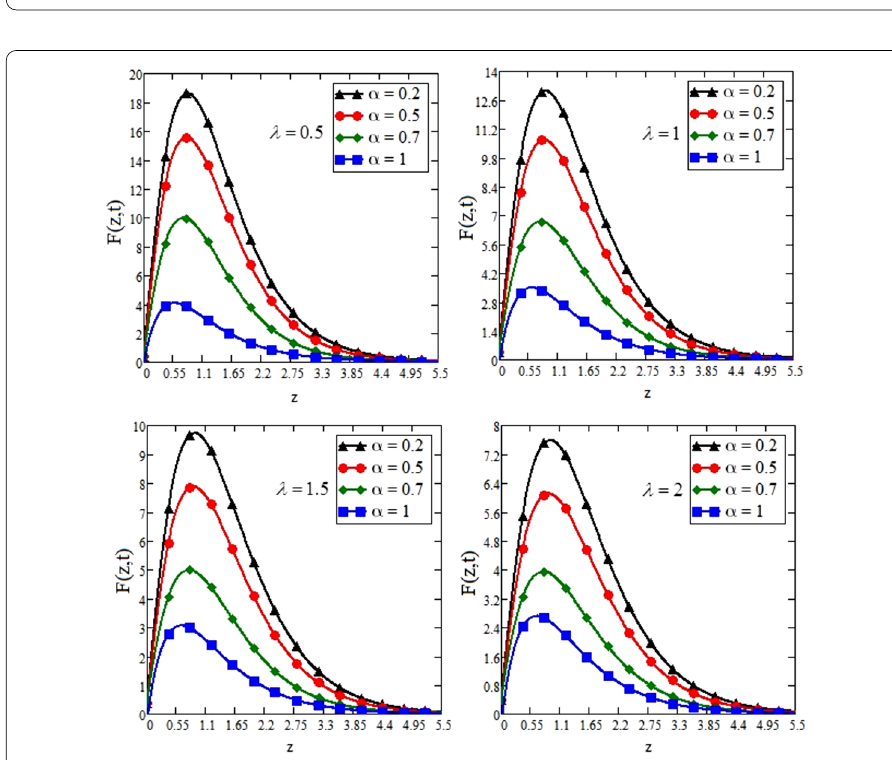
Figure 5 Impact of λ on the velocity distribution of Jeffrey